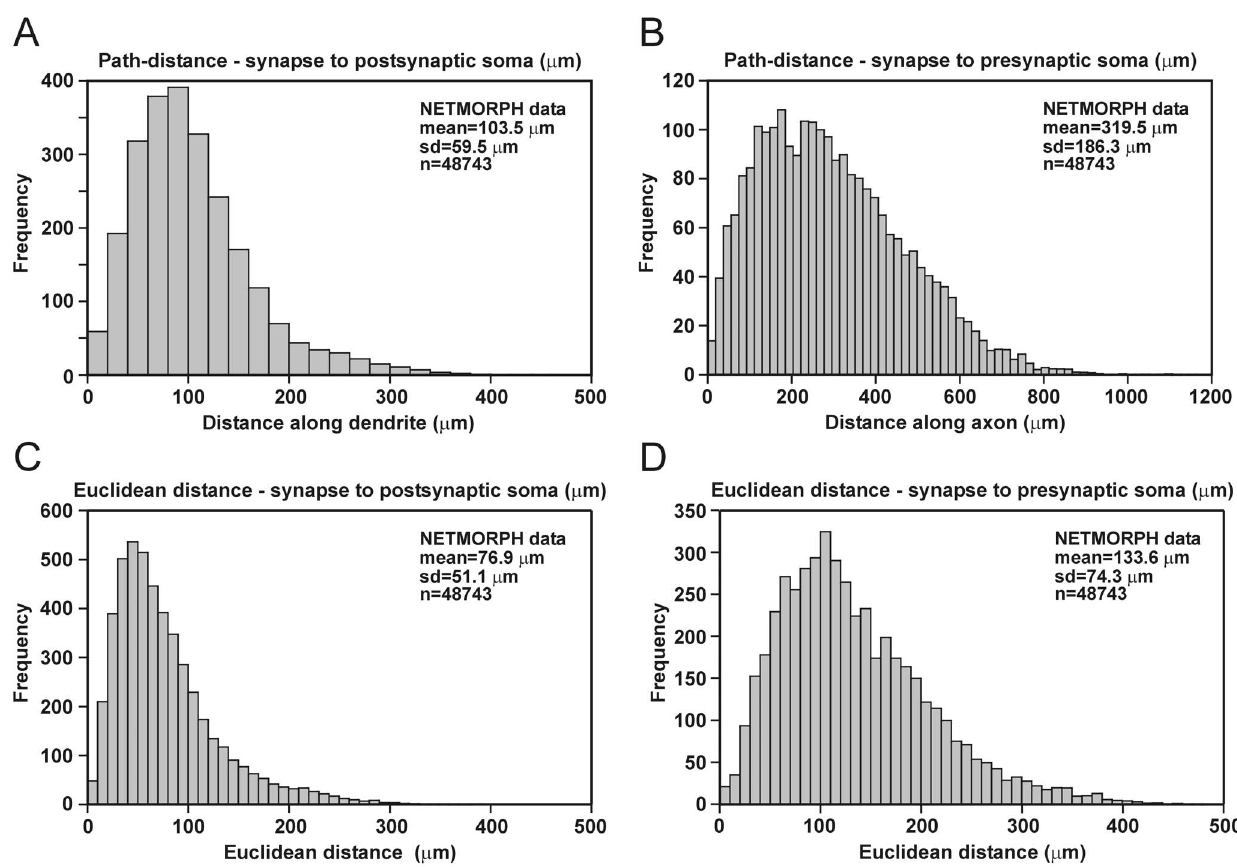
Figure 5. Distribution of path and Euclidean distances of synapses to their post- and presynaptic somata. A , Path distance to postsynaptic soma. B , Path distance to presynaptic soma. C , Euclidean distance to postsynaptic soma. D , Euclidean distance to presynaptic soma.